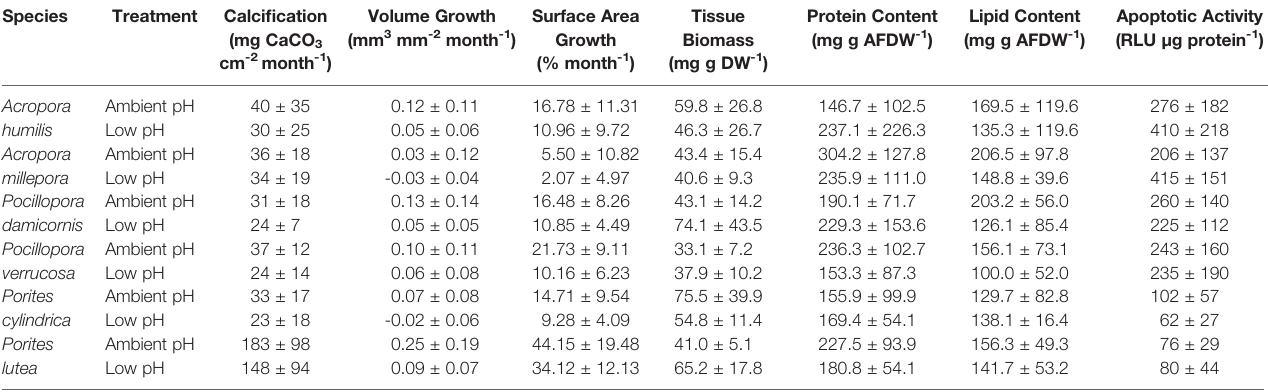
TABLE 2 | Physiological parameters (mean ± sd) of Acropora humilis , Acropora millepora , Pocillopora damicornis , Pocillopora verrucosa , Porites cylindrica , and Porites lutea maintained in ambient and low pH treatments, for three months. Species